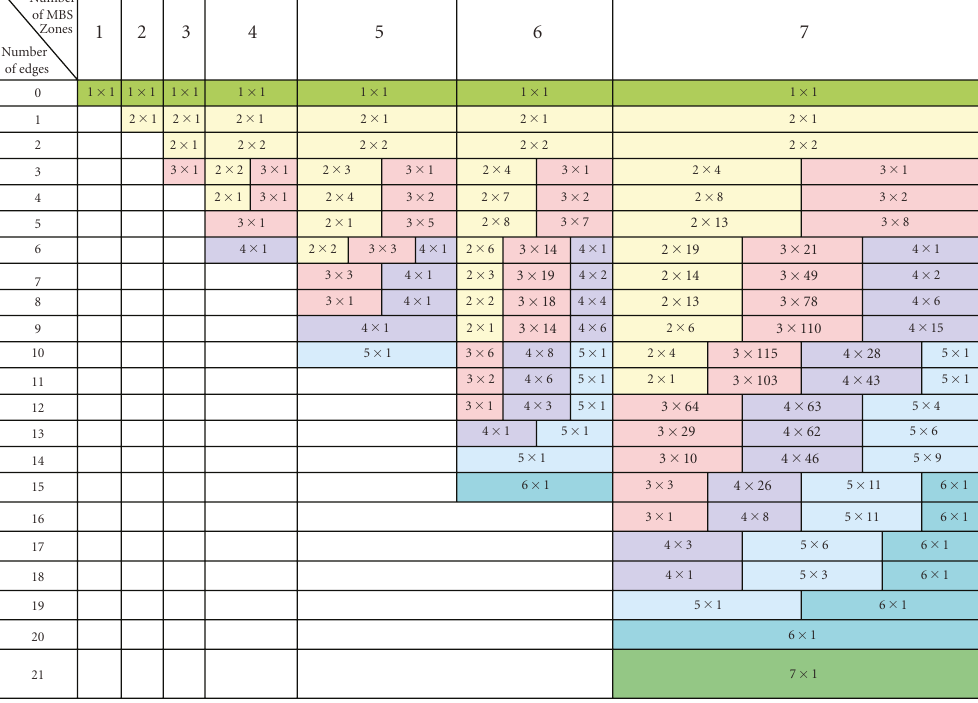
Figure 6: The number of nonisomorphic graphs ( n ) and the required radio resource units per nonisomorphic graph ( m ) for overlapping MBS zones, m × n